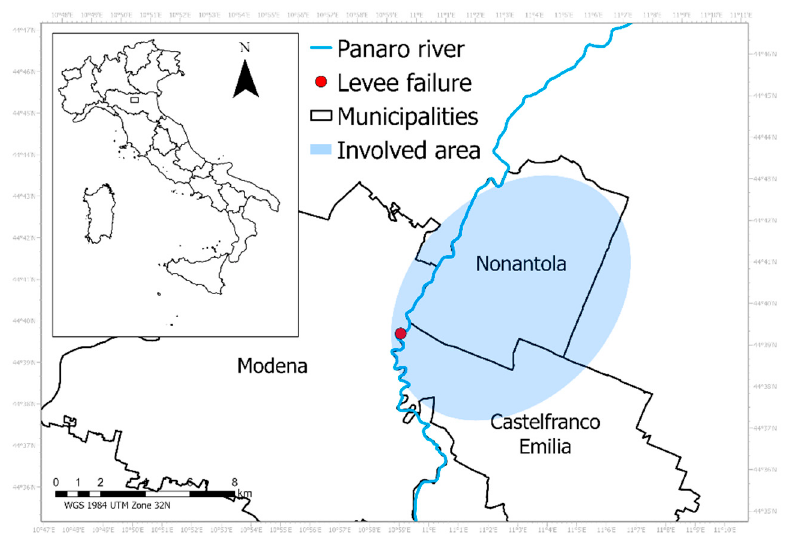
Figure 2. Case study: levee failure in the municipality of Castelfranco Emilia that caused river Panaro flooding.